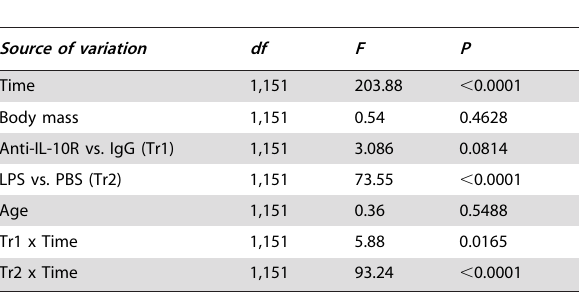
Figure 3. Changes in body mass of mice treated with anti-IL-10R antibodies or IgG. (A) young individuals; (B) old individuals. The bars represent the mean 6 SE. doi:10.1371/journal.pone.0012940.g003 Table 3. Generalized linear mixed model reporting the effect of the experimental treatments and age on the temporal variation (day 0, and 8) in the plasma concentration of the serum amyloid